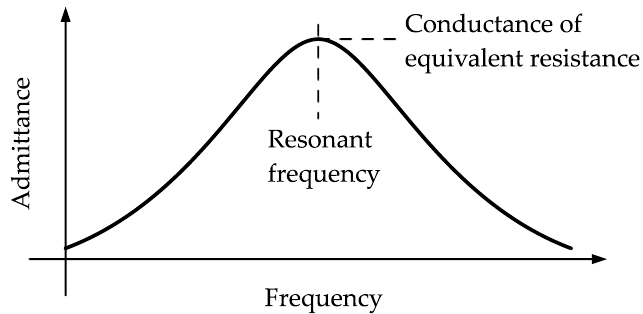
Figure 3. Schematic frequency characteristic of the admittance of LC resonant circuit.